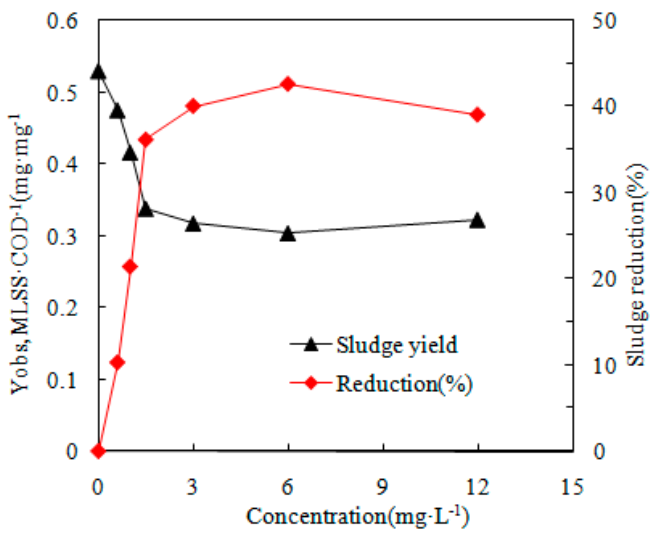
Figure 1. Changes in the sludge yield (Yobs) and sludge reduction rate (SR).